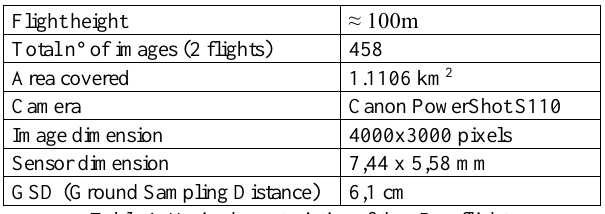
Table 1. Main characteristics of the eBee flight.